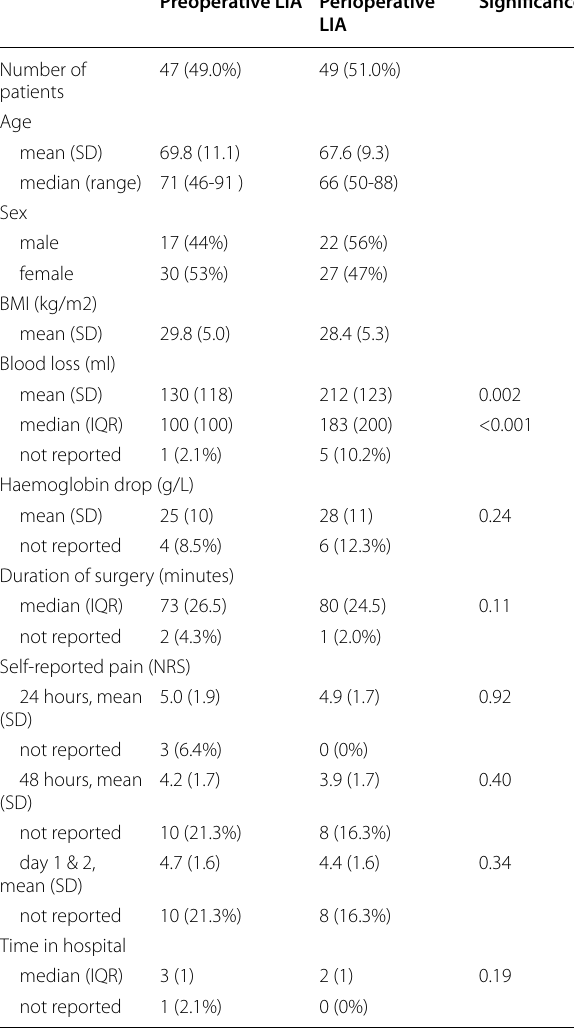
Table 1 Comparison of intervention and control group Preoperative LIA Perioperative Significance LIA Number of